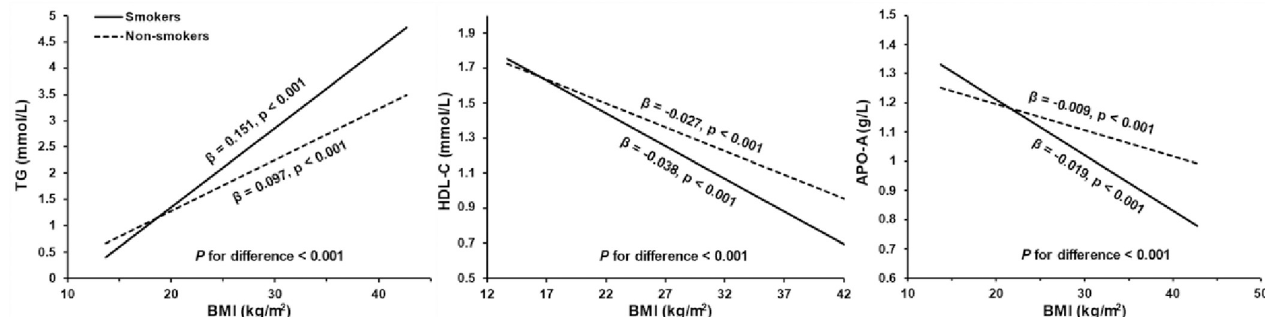
Fig 1. Relationship between body mass index (BMI) and lipid profiles in smokers and non-smokers. TG = triglyceride; HDL-C = high density lipoprotein cholesterol; Apo-A = apolipoprotein A; Covariates for adjustment included age, sex, region, energy intake and